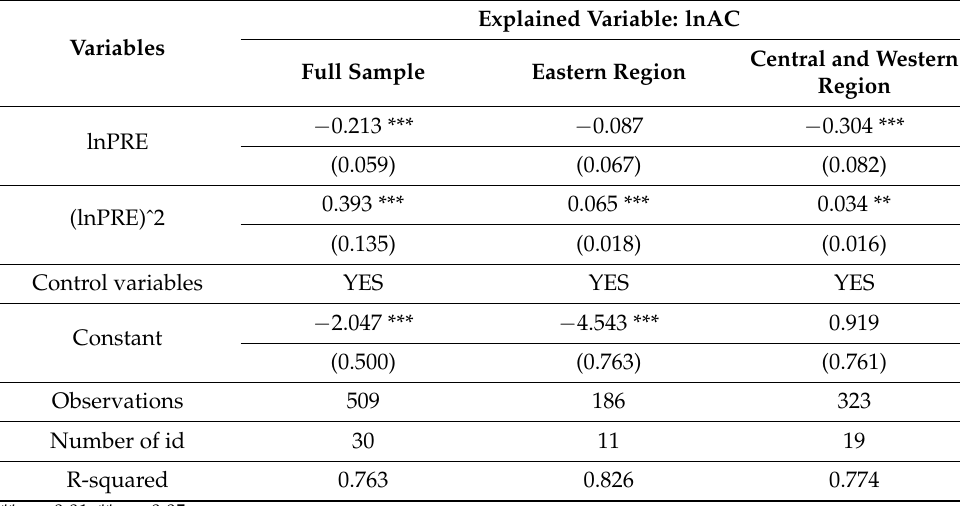
Table 8. Regression results of economic growth pressure on carbon